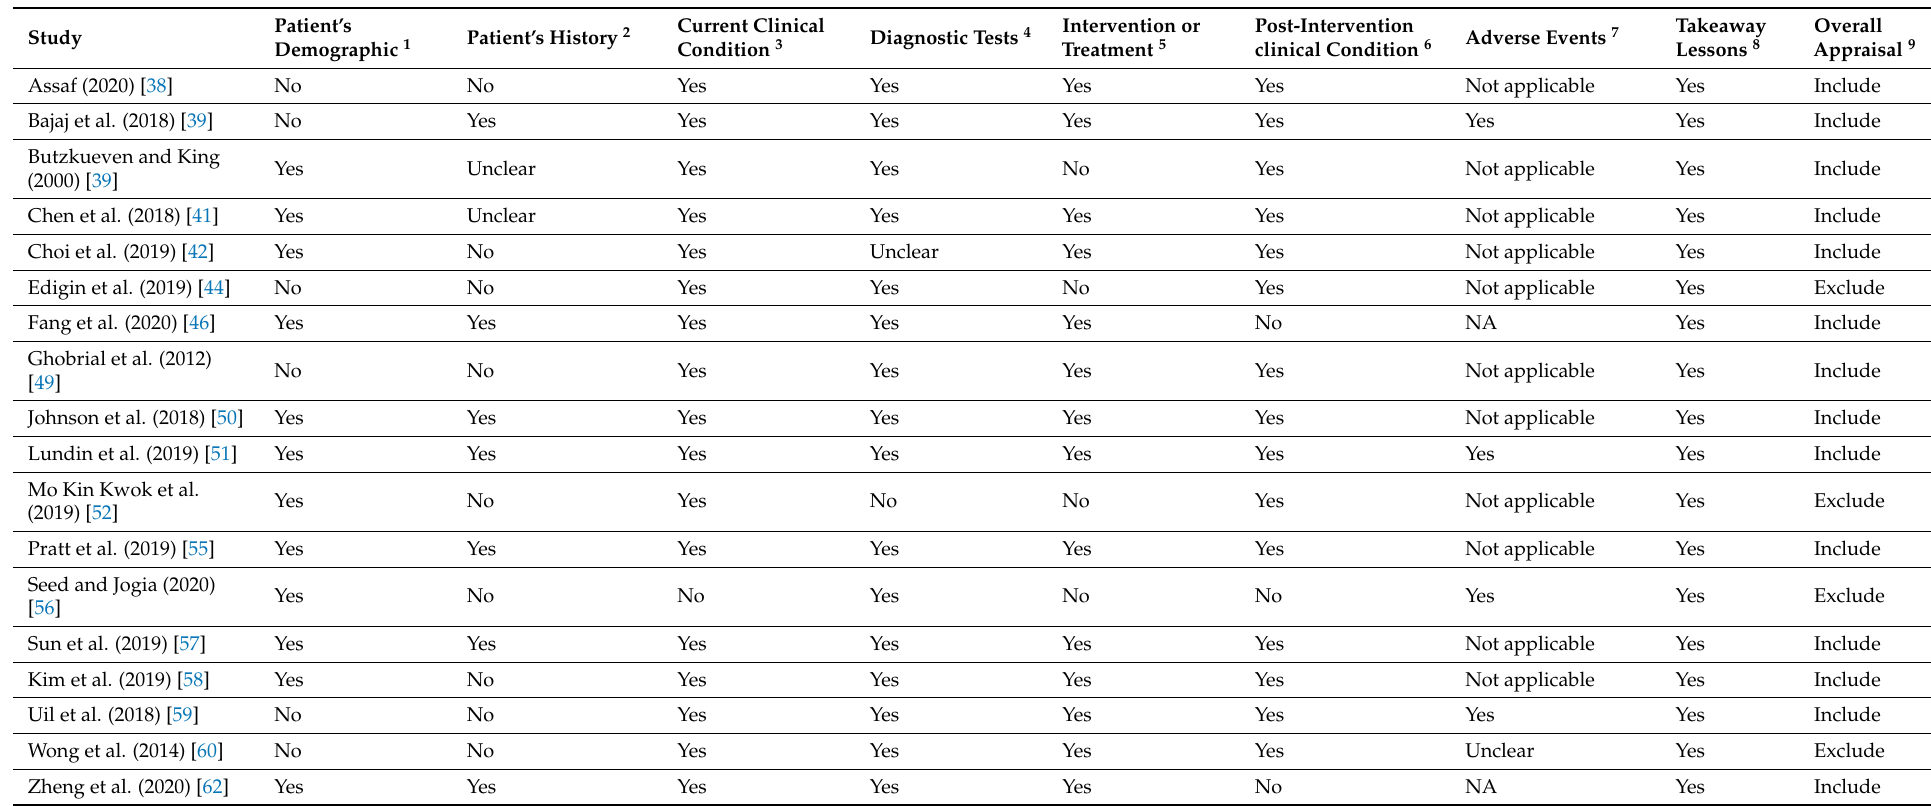
Table 3. JBI Quality Assessment of Case